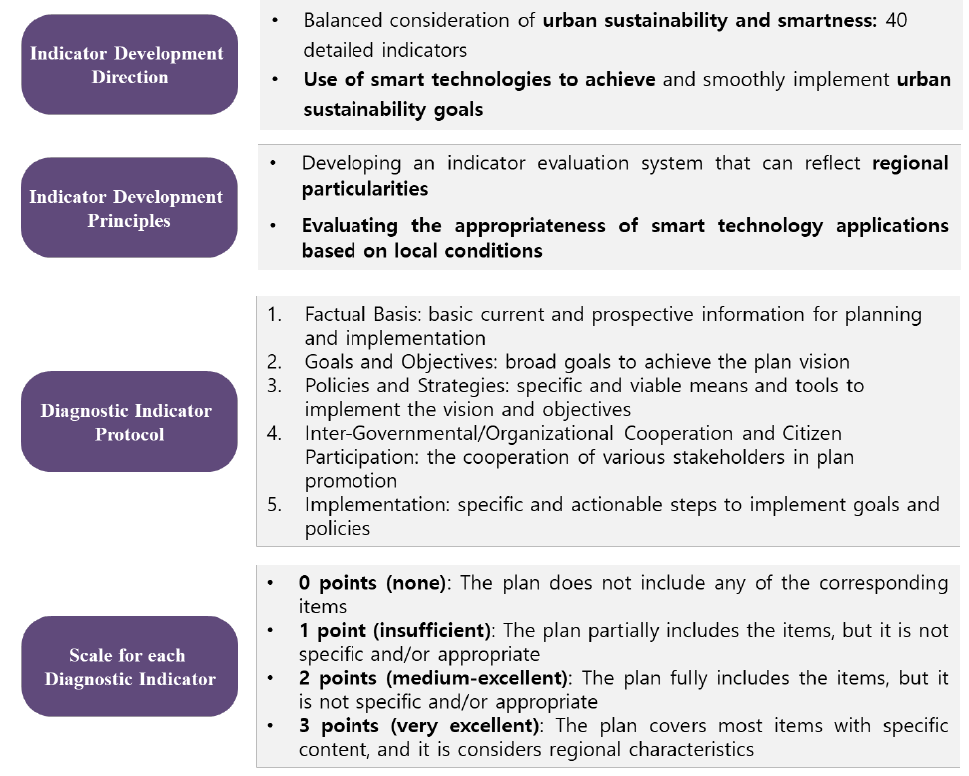
Table 1. Smart sustainable city evaluation and diagnosis indicators.